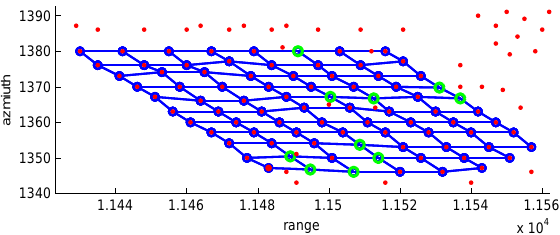
Figure 8: Lattice in SAR geometry. The red dots are Persistent Scatterers. Blue shows the aggregated lattice structure obtained by our production system approach. The green circles mark gaps in the lattice structure where no valid PS could be found in the neighborhood of the corresponding lattice position.